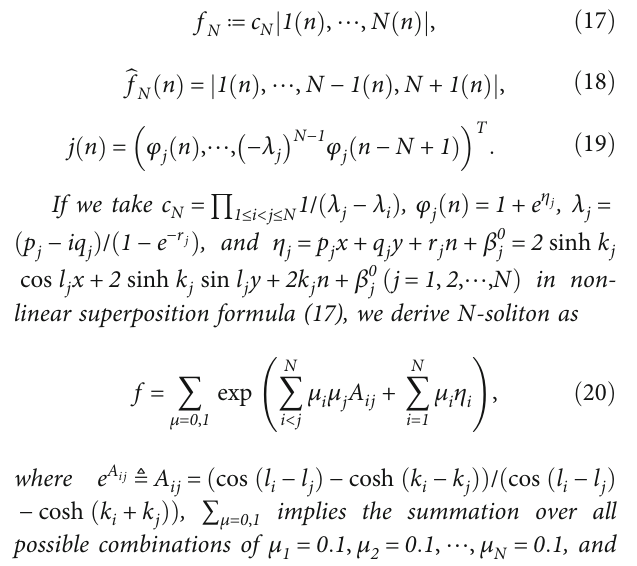
ffiffiffi p = β = 0 , γ = γ = 0 , δ = 1 : 7/ 3 , and δ 2 = 1 : 6/ 1 1 2 1 2